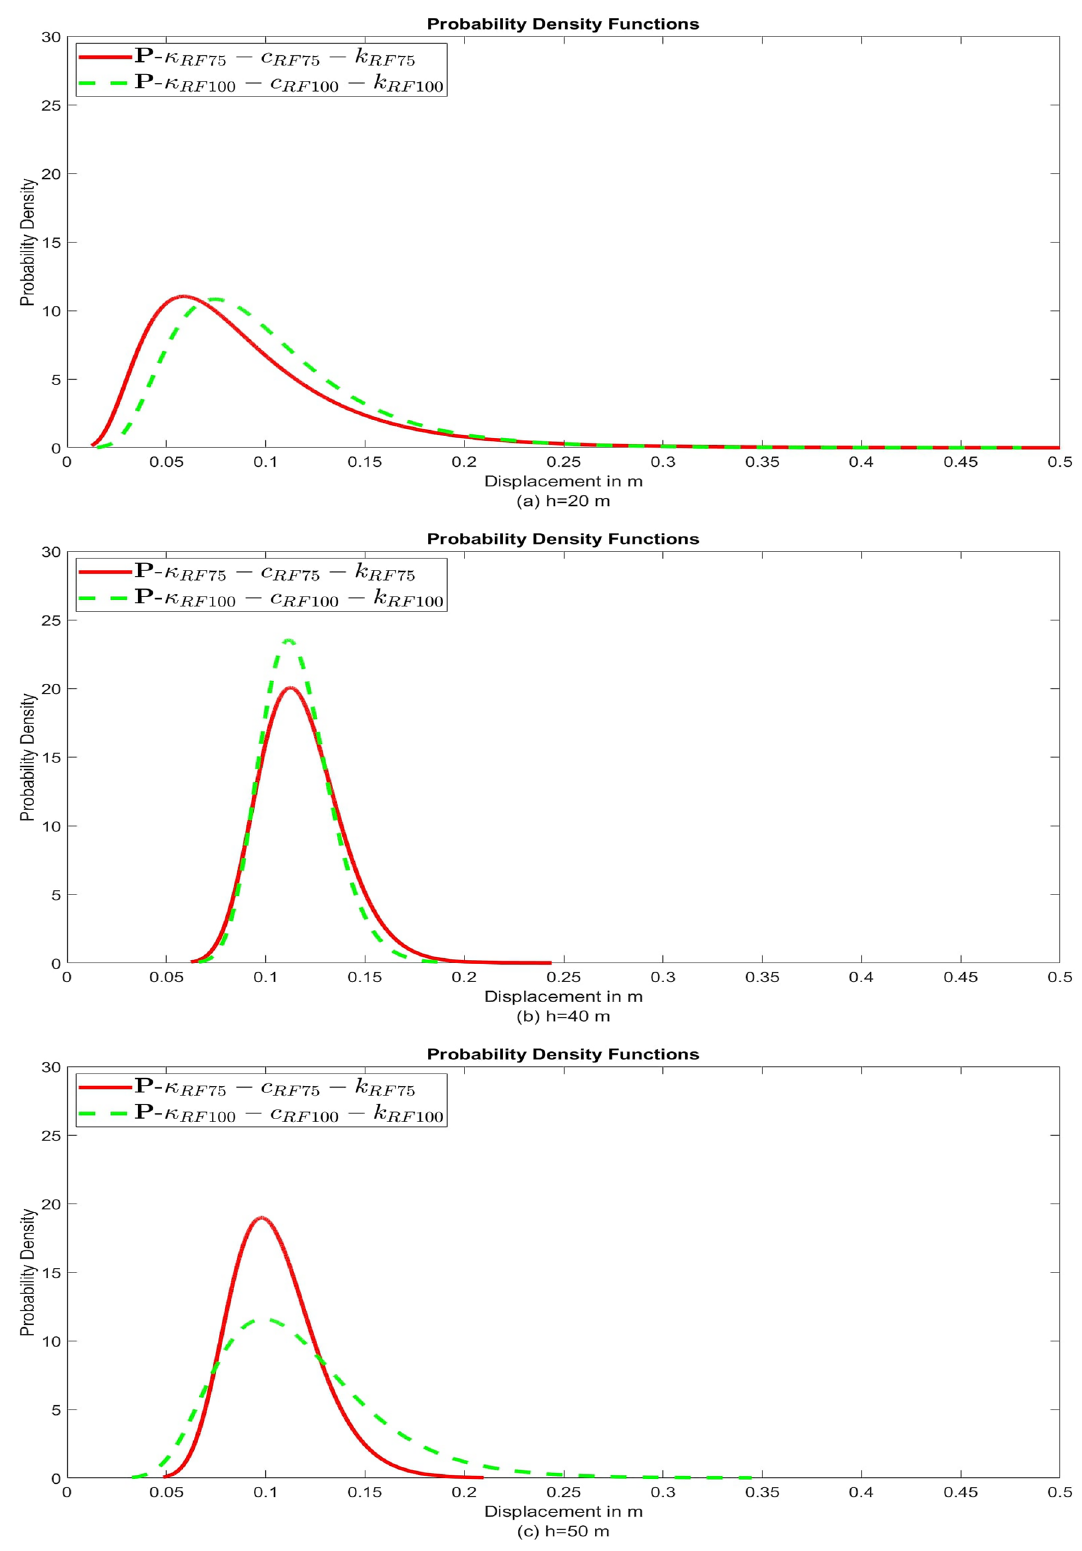
Fig. 12 PDFs of failure displacements of porous analyses with random field representation for all stochastic material